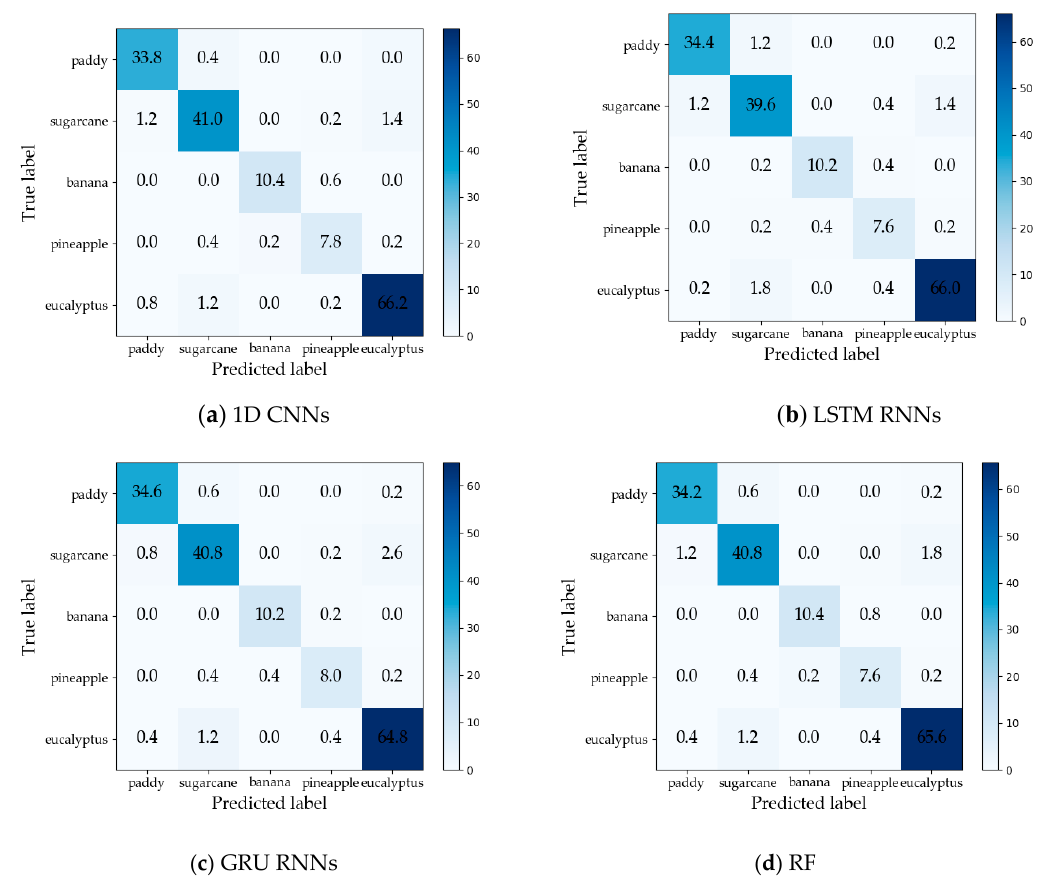
Figure 12. Confusion matrices (averages from five test sets) on the time series data with the maximum overall accuracies (OAs) of the different approaches: ( a ) 1D CNNs; ( b ) LSTM RNNs; ( c ) GRU RNNs; and ( d ) RF. Table 5. Producer’s accuracy (PA) on the time series data with the maximum OAs. Bolded values are the best performances (PA) of each crop type in different classifiers.